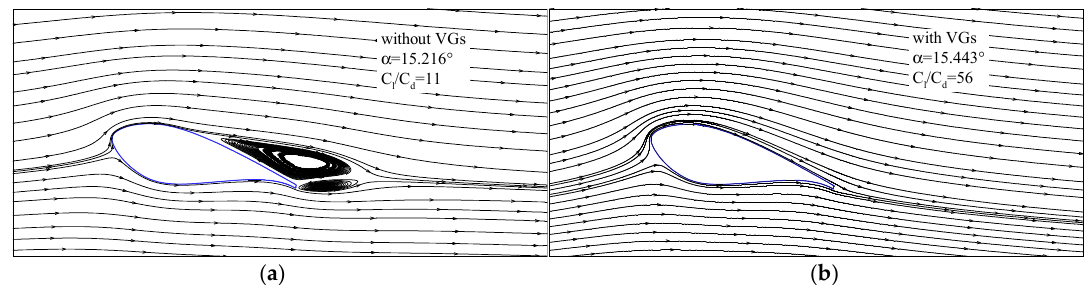
Figure 8. Streamlines of the uncontrolled and controlled airfoil flow at α = 15 ° : ( a ) without VGs; ( b ) with VGs.